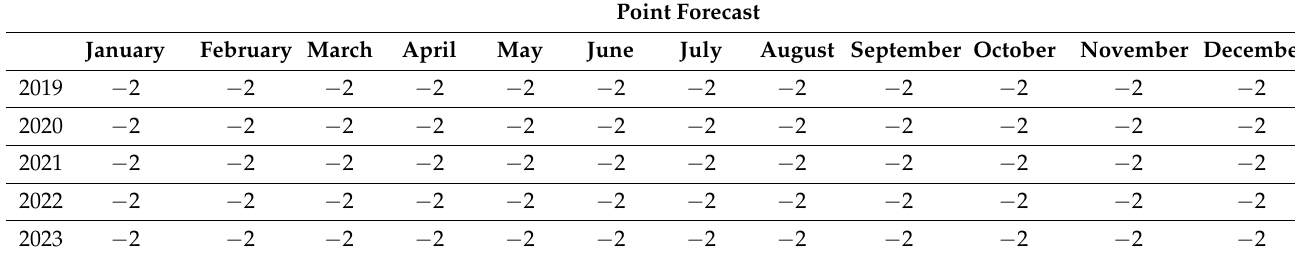
Table 17. Point forecasted value of SPEI-9 for five years. Point Forecast